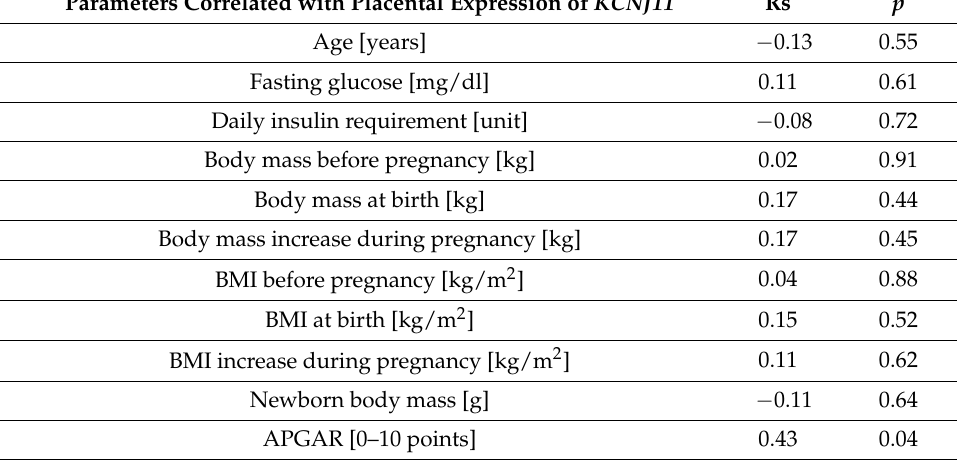
Table 8. Correlations between KCNJ11 expression in the placenta and clinical parameters in the GDM group.